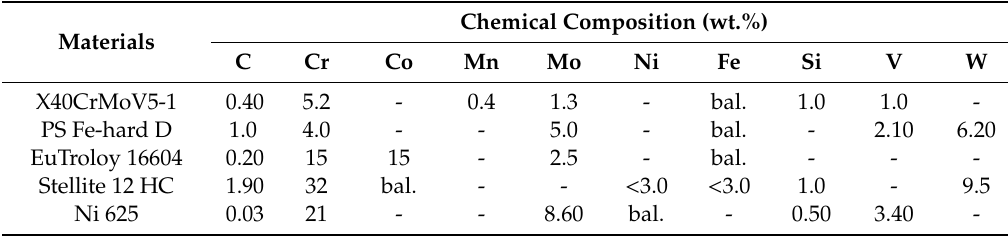
Table 1. Types and chemical composition of the used materials in the investigations [16,17].